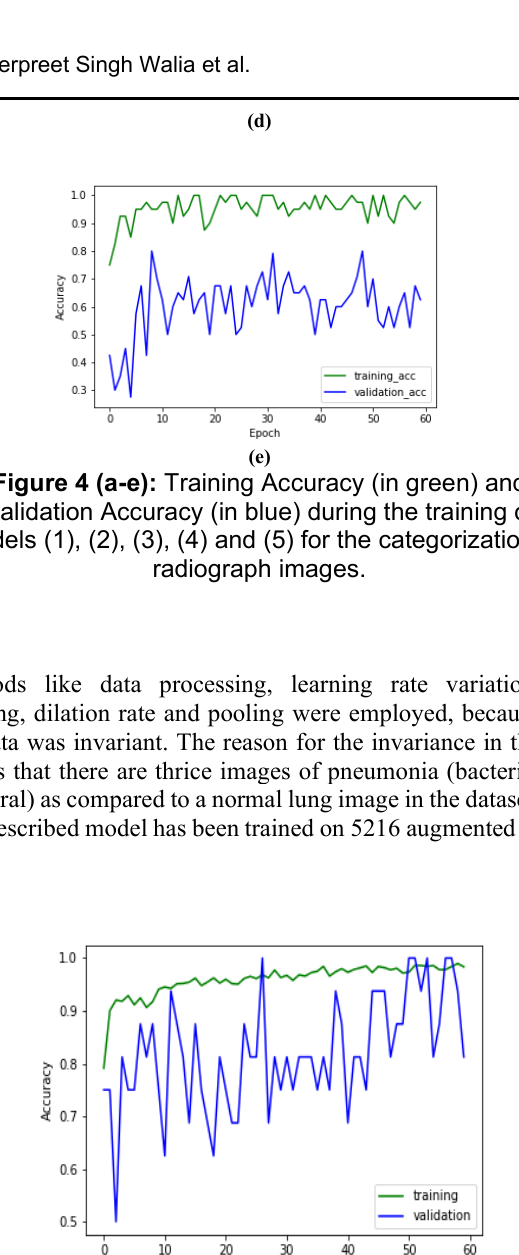
Figure 6(a): Training Accuracy (in green) and Validation Accuracy (in blue) during the training of model for the categorization of radiograph images;